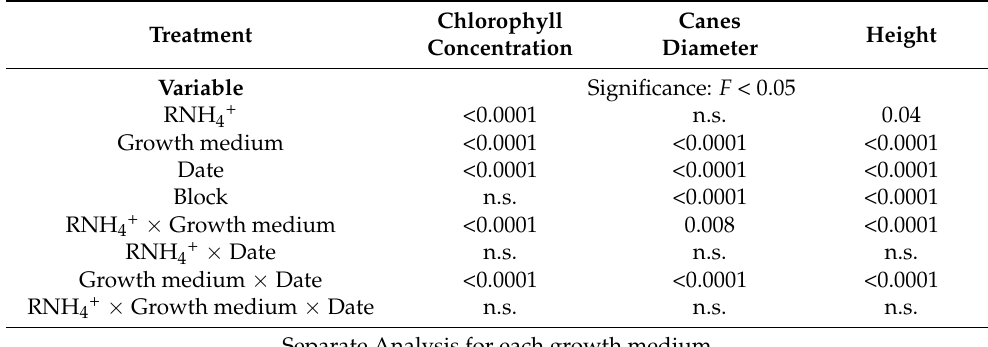
Table 4. The effects of proportions of N-NH 4+ among the total applied inorganic N (RNH 4+ ) [RNH 4+